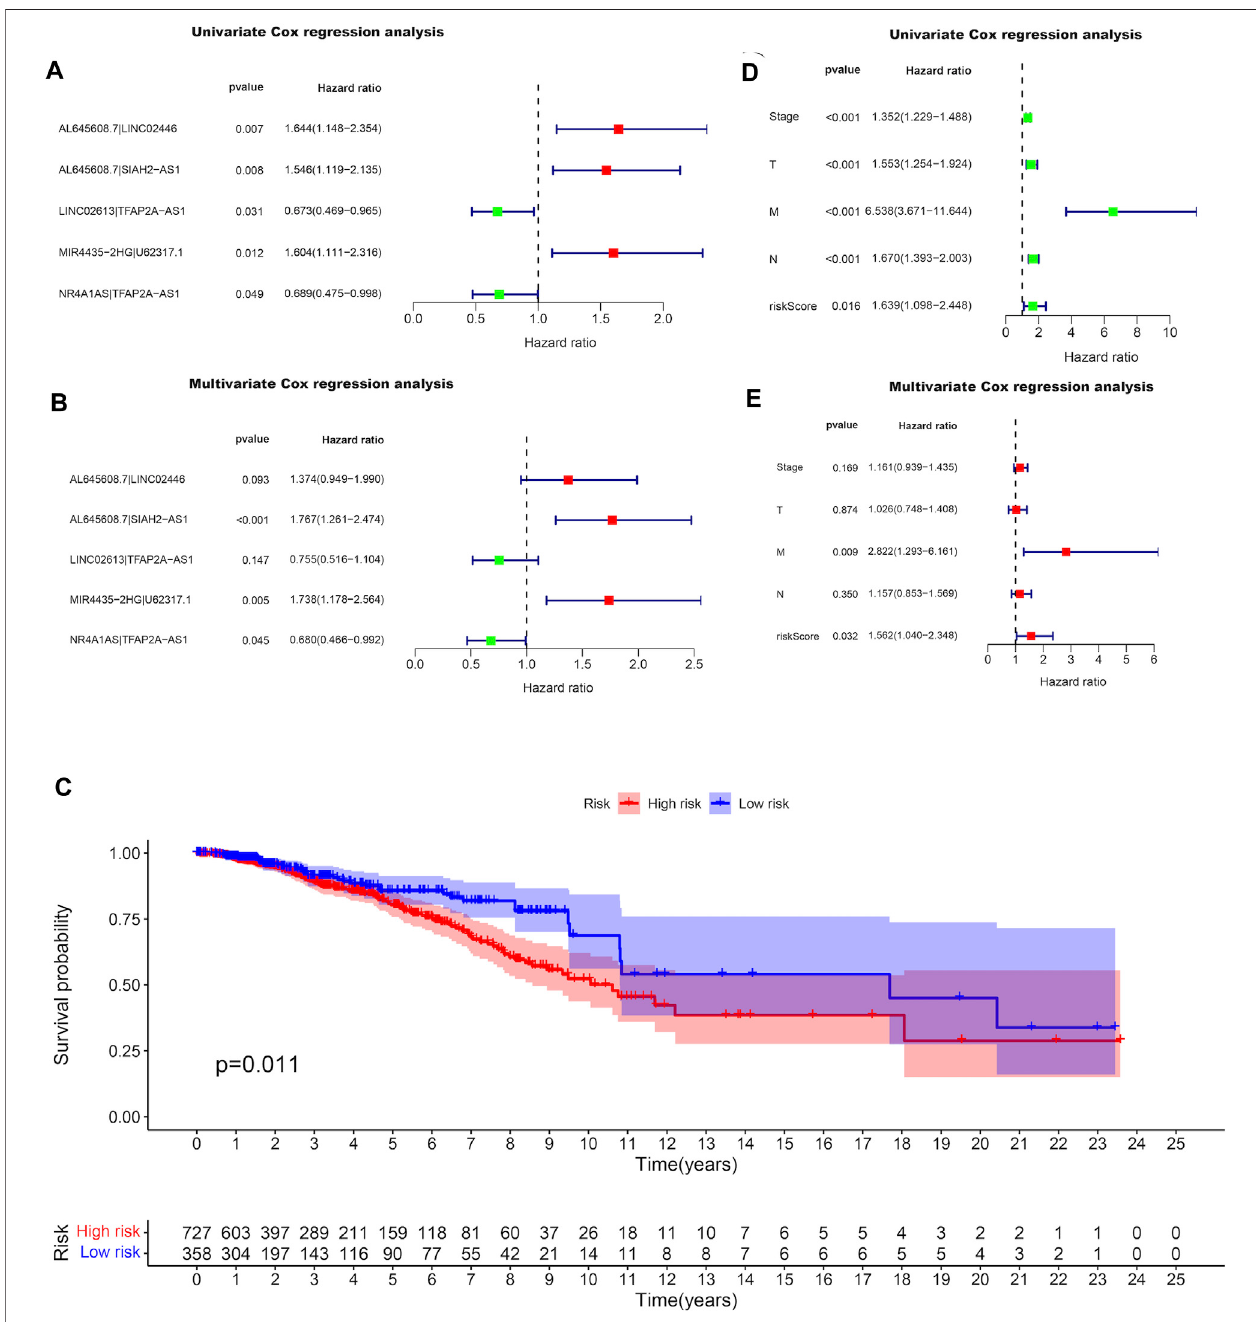
FIGURE 2 | Differentially expression of irlncRNA pairs with prognostic value in BRCA. Forest plots display the differential expression of irlncRNAs pairs associated withOS.HRand95%CIwerecalculatedbytheLASSOunivariate (A) andmultivariate (B) coxregressionanalysis. (C) Kaplan-Meiersurvivalcurvesofthehigh-riskgroup and the low-risk group de fi ned with the expression of lncRNA MIR4435-2HG and lncRNA U62317.1. Forest plots display that the univariate (D) and multivariate (E) cox regression analyses were performed for the analysis of clinicopathological features with the pair MIR4435-2HG|U62317.1.